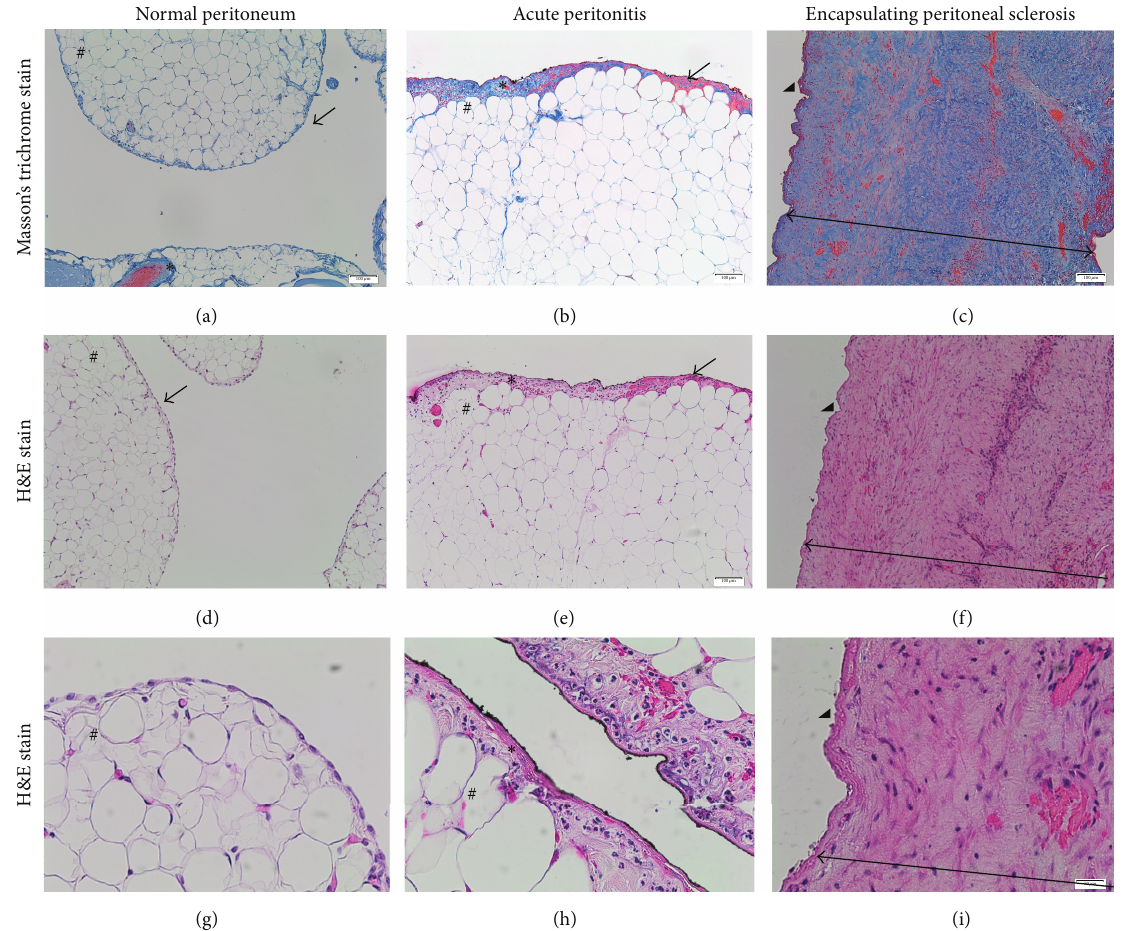
Figure 2: Peritoneal biopsies representative photomicrographs of haematoxylin-eosin and Masson’s trichrome stainings in studied cases (a, d, and g). Mesothelium ( → ) and adipocytes (#) in the submesothelial area in normal peritoneal membrane (b, e, and h). Well preserved mesothelium with hyperplasic mesothelial cells and increase in conjunctive tissue ( ∗ ) associated with interstitial submesothelial infiltrate mainly polymorphonuclear neutrophils (++) in acute peritonitis case. Superficial black lining related to the surgery technique (use of Indian ink). (c, f, and i) Disappearance of mesothelium (arrowhead), major submesothelial fibrosis containing mainly mononuclear cells, and sever fibrosis ( ←→ ) in case of EPS. Original magnifications: (a–f) × 10, (g–i) ×